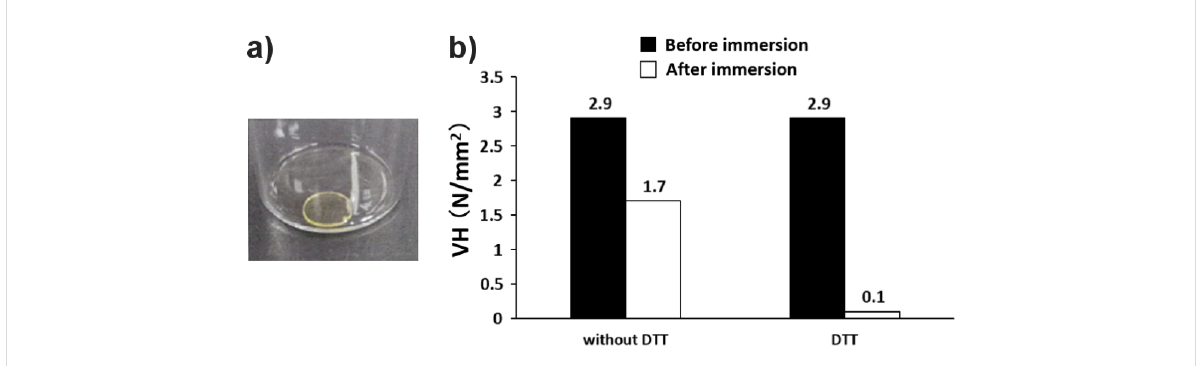
Figure 4: a) Image of the photosetting plastic prepared by resin casting and b) the results of the Vickers hardness (VH) measurement before and after the treatment with